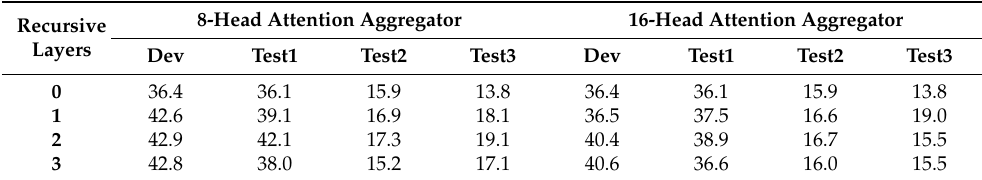
Table 5. The Micro F1 values on the different multi-head attention aggregators with different recursive layers